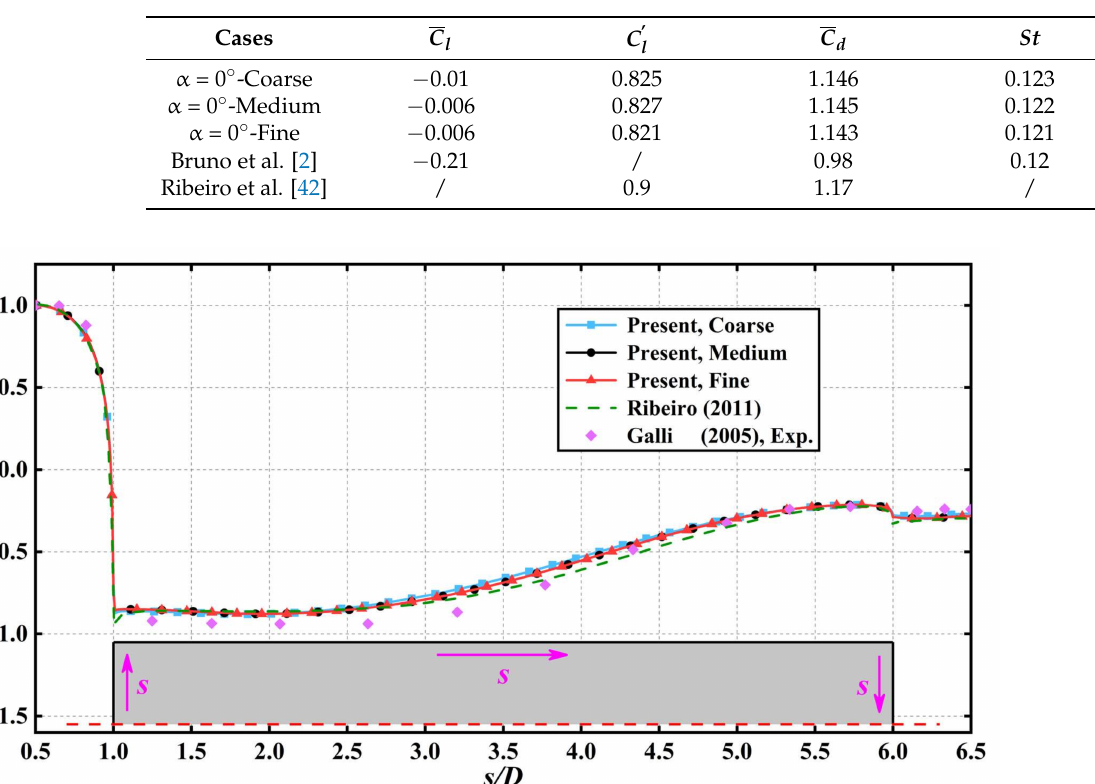
Table 2. Comparison of lift and drag coefficient and Strouhal number.